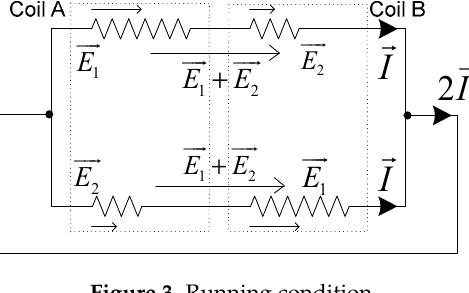
Figure 3. Running condition.